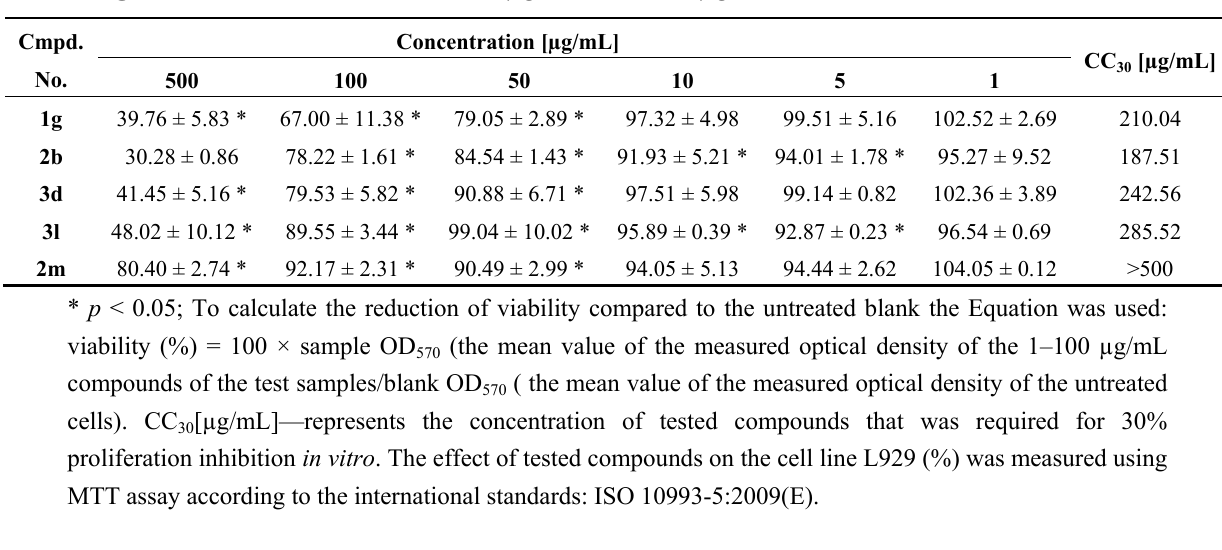
Table 2. The viability of L929 cells ( in % of viable L929 cells ) in the concentration range of 1g , 2b , 2m , 3d , and 3l between 1 µg/mL and 500 µg/mL ±